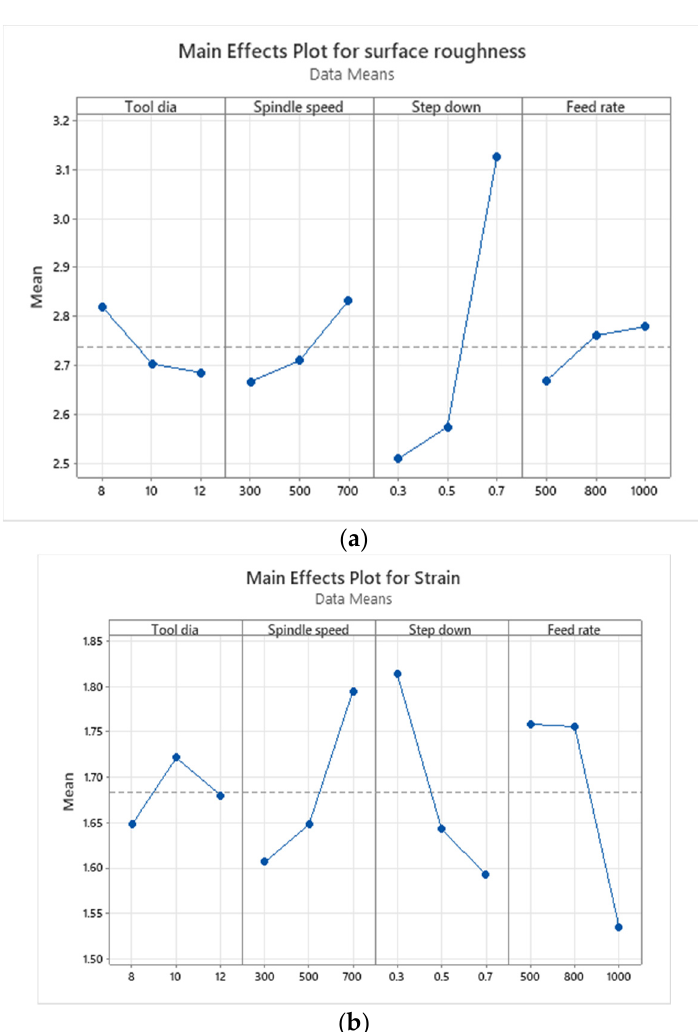
Figure 9. Mean effect plot for ( a ) surface roughness and ( b ) strain .